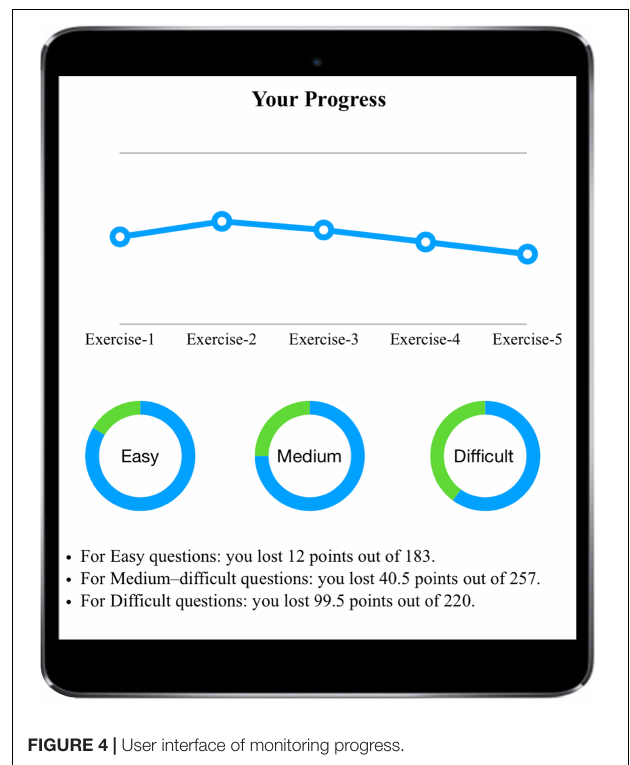
FIGURE 3 | User interface of a summarized report of students’ answers.